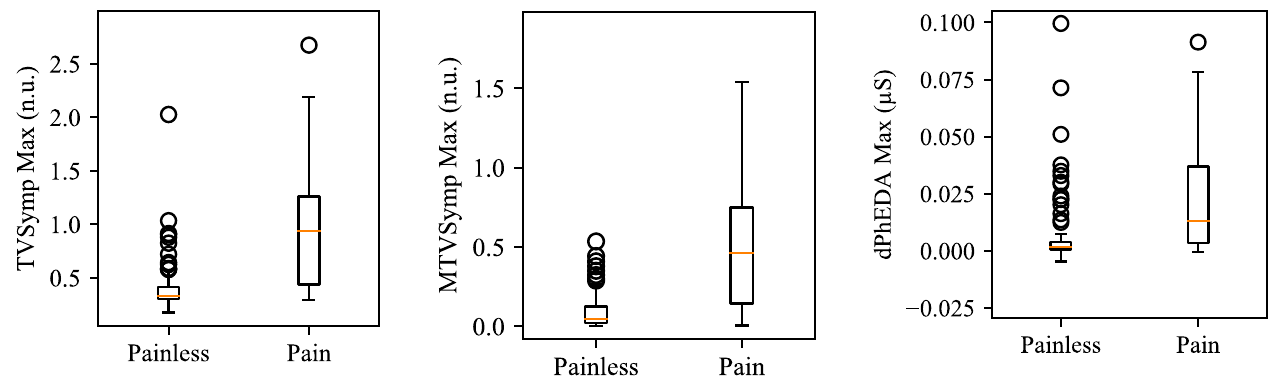
Figure 10. Boxplots for maximum values of TVSymp, MTVSymp, and dPhEDA for TG dataset. The circles in the boxplots indicate outliers. Outliers were set if each datum is above Q1 − 1.5 × (Q3 − Q1) or below Q3 + 1.5 × (Q3 − Q1). Q1 and Q3 represent the first and third quartiles, respectively. Table 6. Statistical analysis on difference between painless and pain segments for TG dataset.